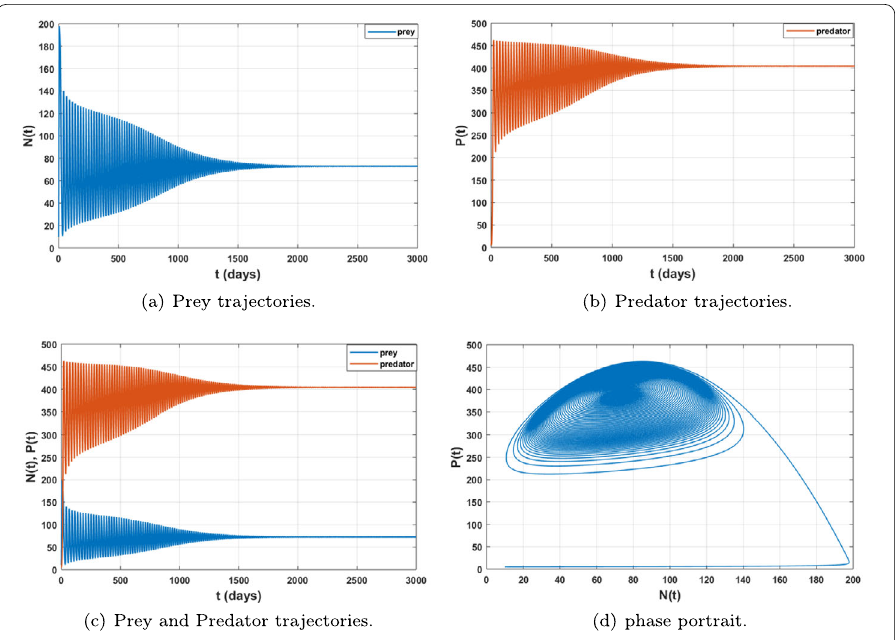
Figure 6 Global asymptotic stability of the coexisting equilibrium of system (2.3) around E – 3 =